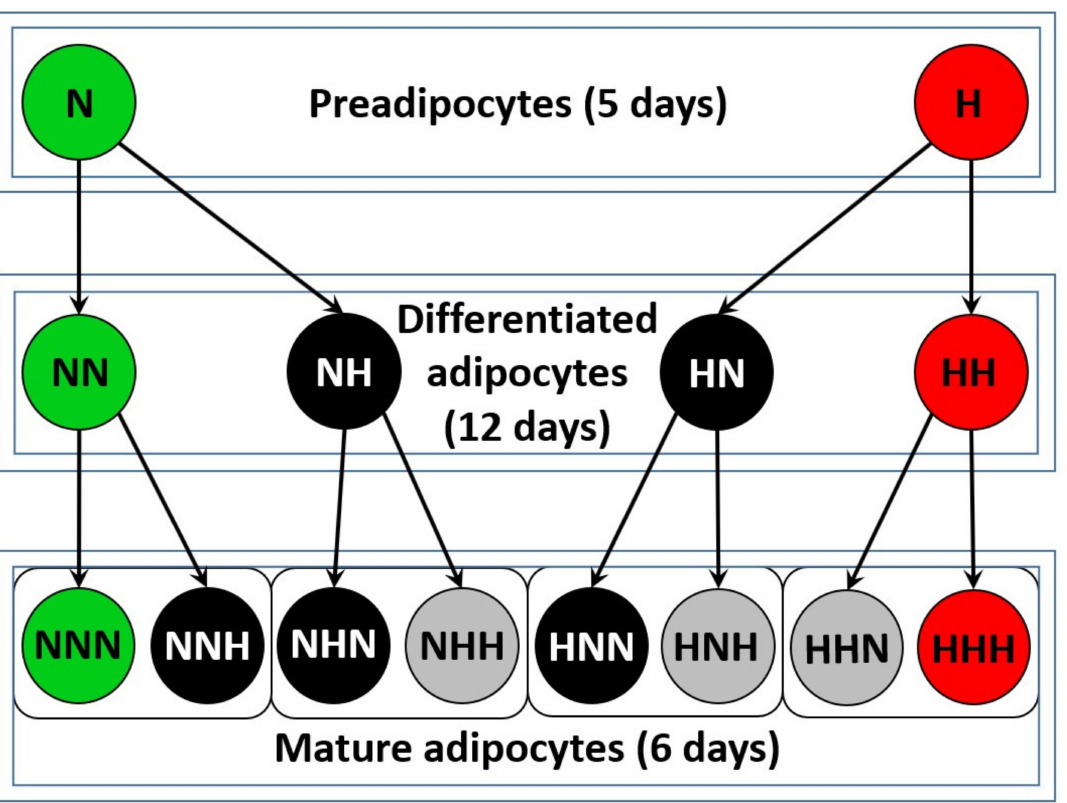
Figure 1. Diagram presenting the human visceral preadipocyte (HPA-v) cell culture research model. Variants of adipogenesis in chronic normoglycemia or hyperglycemia (HG) are colored green and red, respectively. Cells treated with transient HG are colored according to the number of HG stimuli: black denotes single HG stimulus, grey denotes double HG